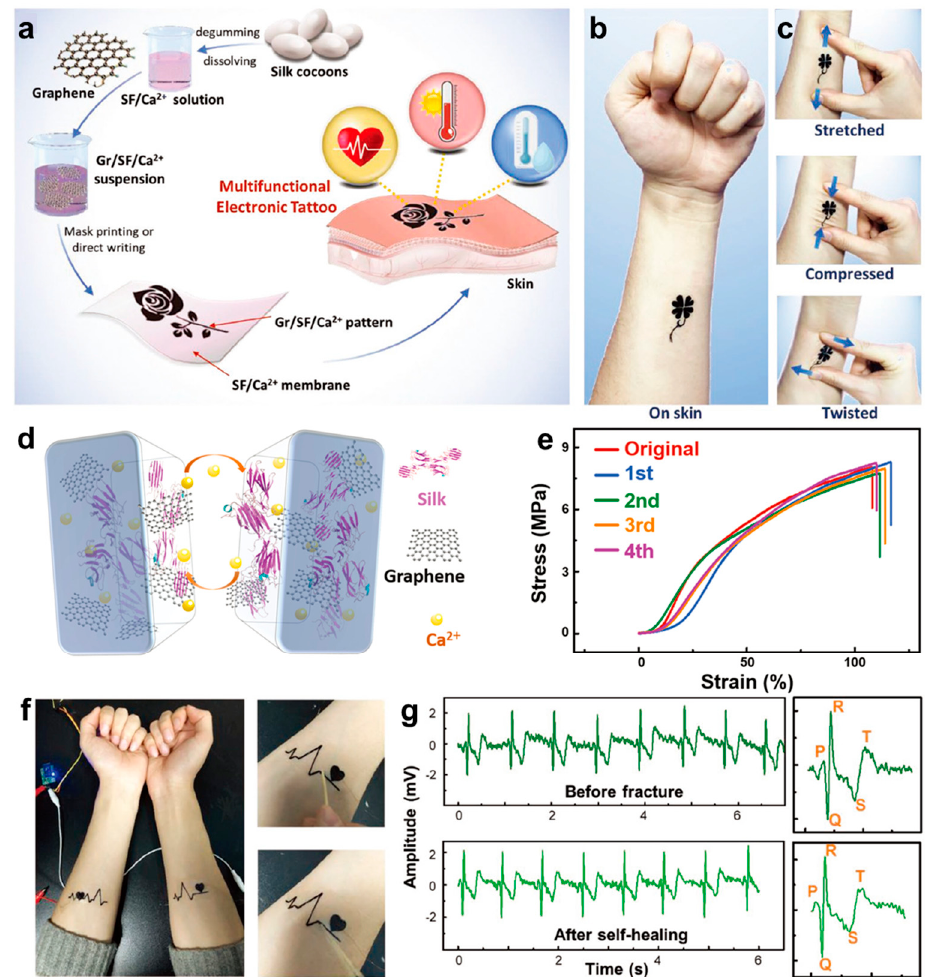
Figure 3. Preparation, characterization and application illustration of Gr/SF/Ca 2+ E-tattoo. ( a ) Schematic procedures for synthesizing Gr/SF/Ca 2+ multifunctional E-tattoo. ( b ) Photograph showing conformal contact between E-tattoo and human forearm. ( c ) Photograph showing the flexibility of E-tattoo on skin under stretching, compressing and twisting. ( d ) Schematic diagram of self-healing property of Gr/SF/Ca 2+ E-tattoo. ( e ) Strain–stress curves of Gr/SF/Ca 2+ E-tattoo after 0, 1, 2, 3 and 4 times of healing. ( f ) Photograph of Gr/SF/Ca 2+ E-tattoo attached on forearms for ECG monitoring. The images on the right illustrate the fractured E-tattoo and recovered E-tattoo. ( g ) ECG signals acquired by original E-tattoo (top) and self-healed E-tattoo (bottom) [118].